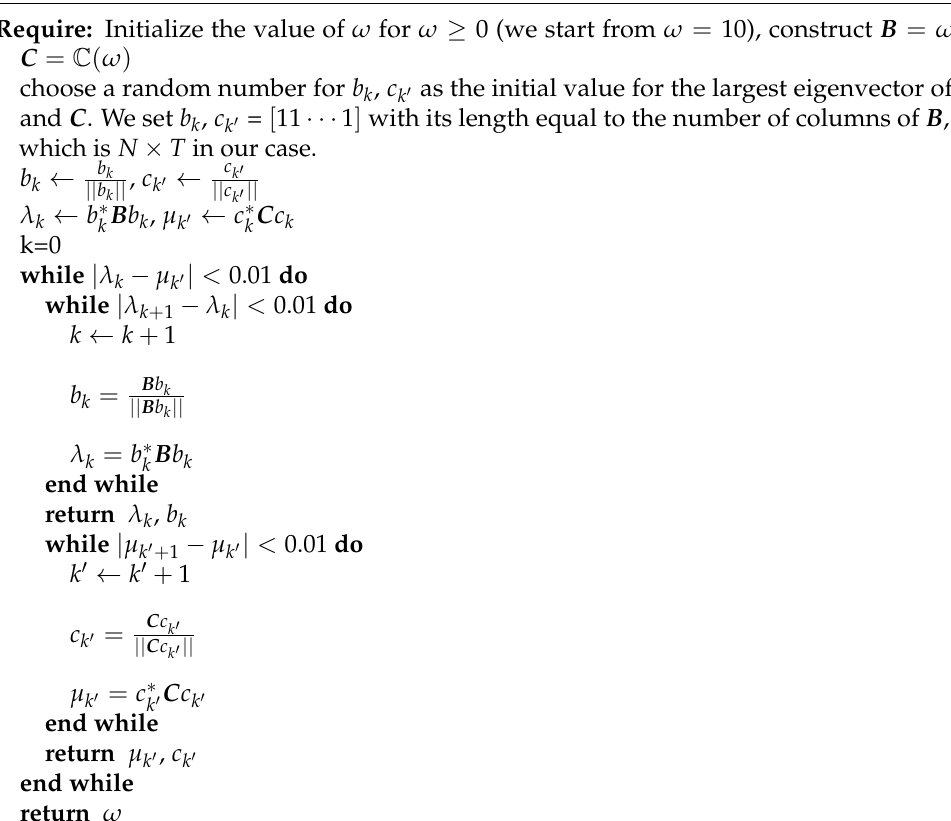
Algorithm 1 Find the appropriate value of